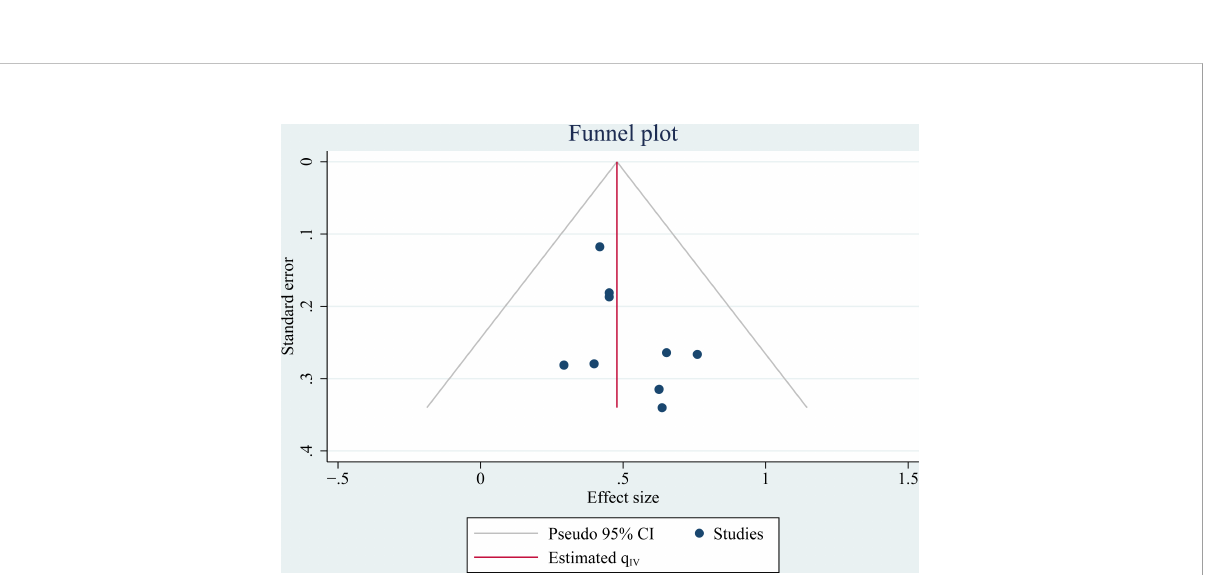
FIGURE 4 Funnel plots for the publication bias underlying the meta-analysis regarding the association between high frailty and OS in patients with